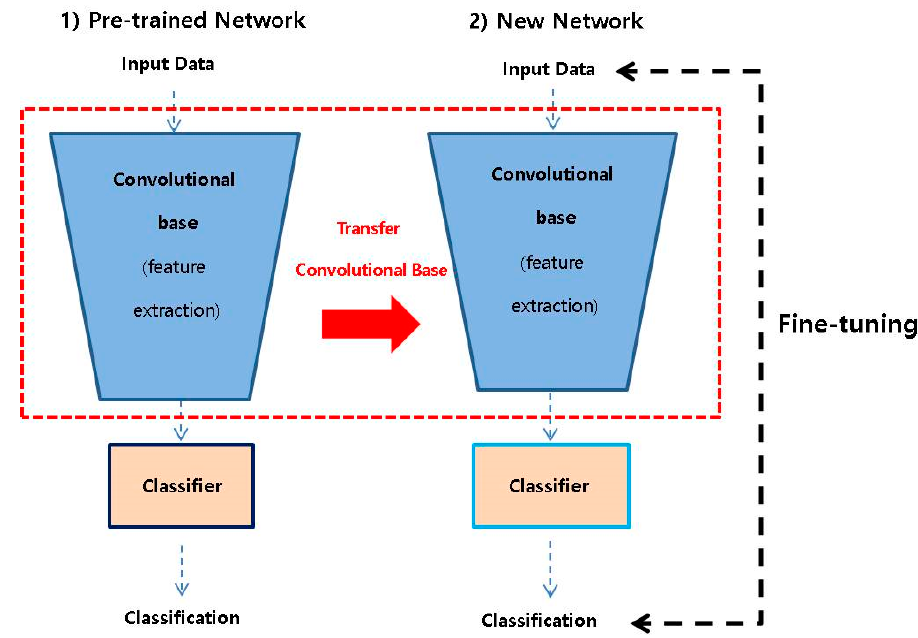
Figure 2. Transfer learning in the proposed approach.